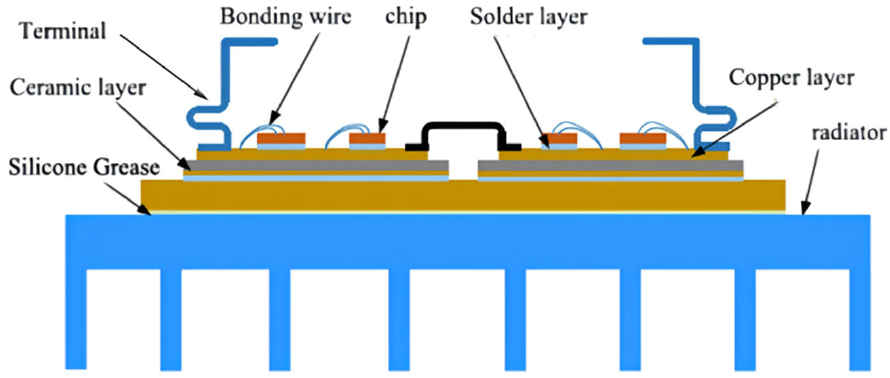
Figure 5. Welded IGBT package structure diagram.